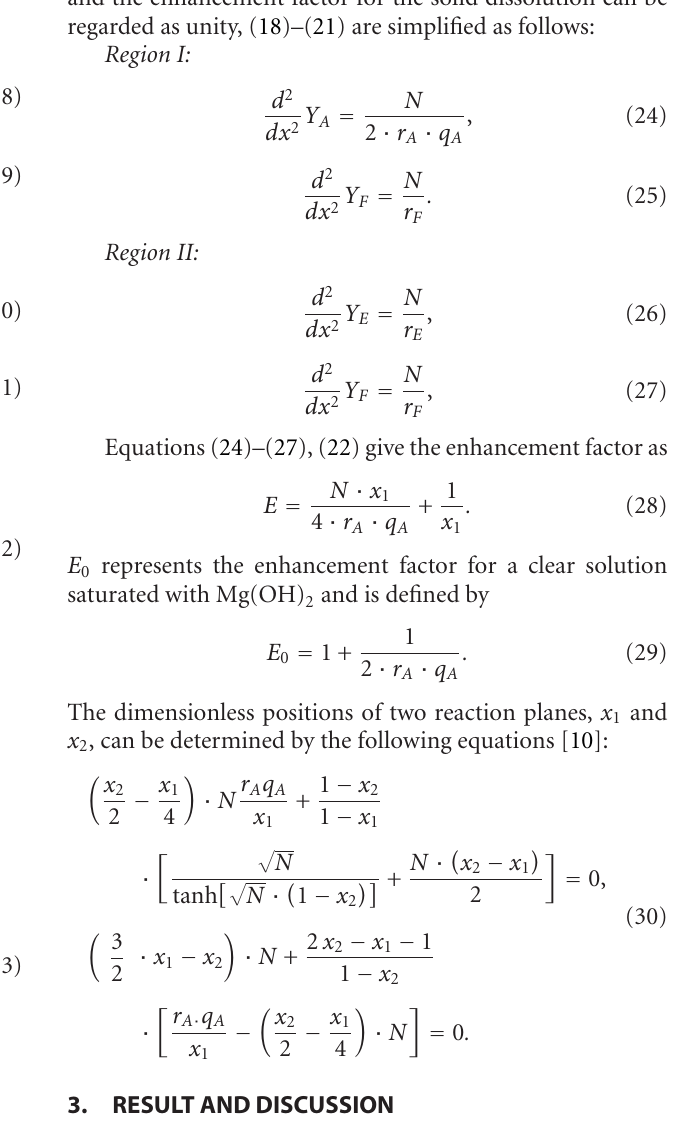
slurry: (a) no suspended solids, (b) in the presence of suspended solids. 2